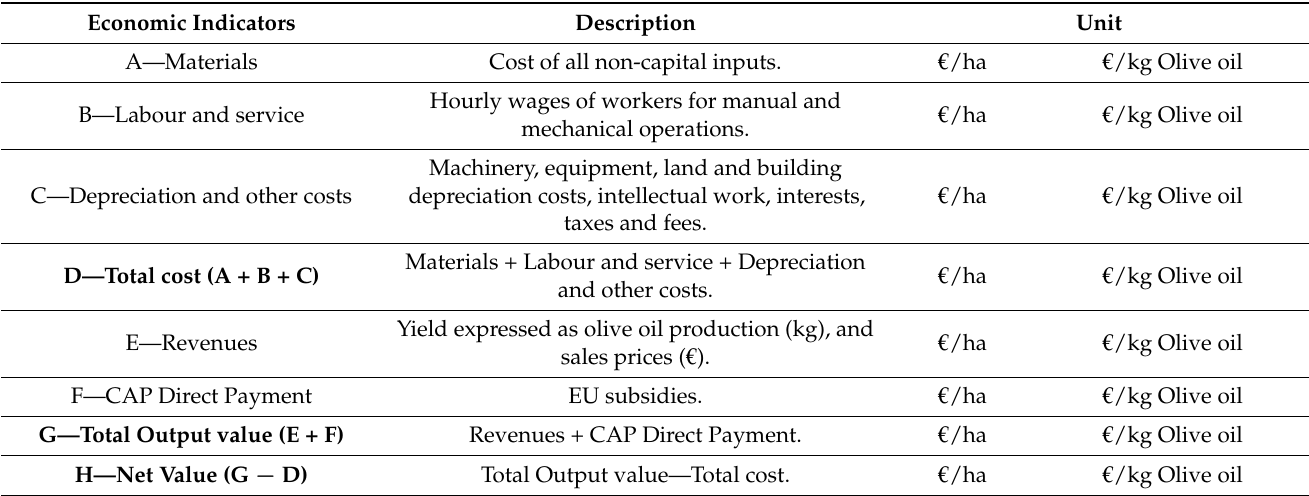
Table 1. Economic indicators